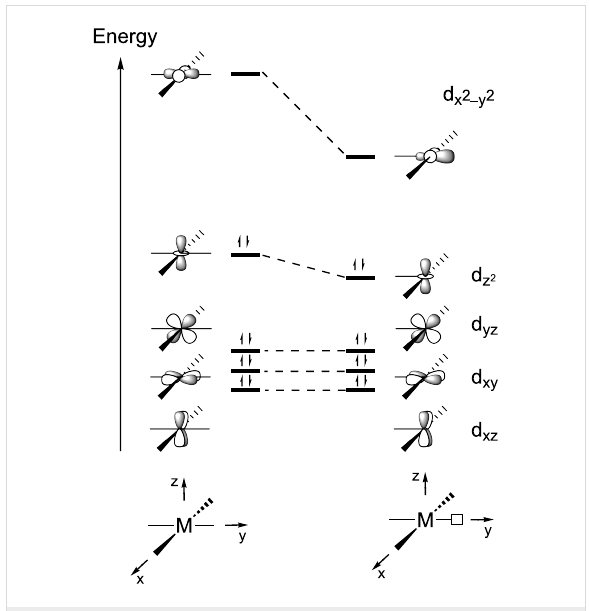
Figure 1: Qualitative orbital diagram for a d 8 metal in ML 4 square- planar and ML 3 T-shaped